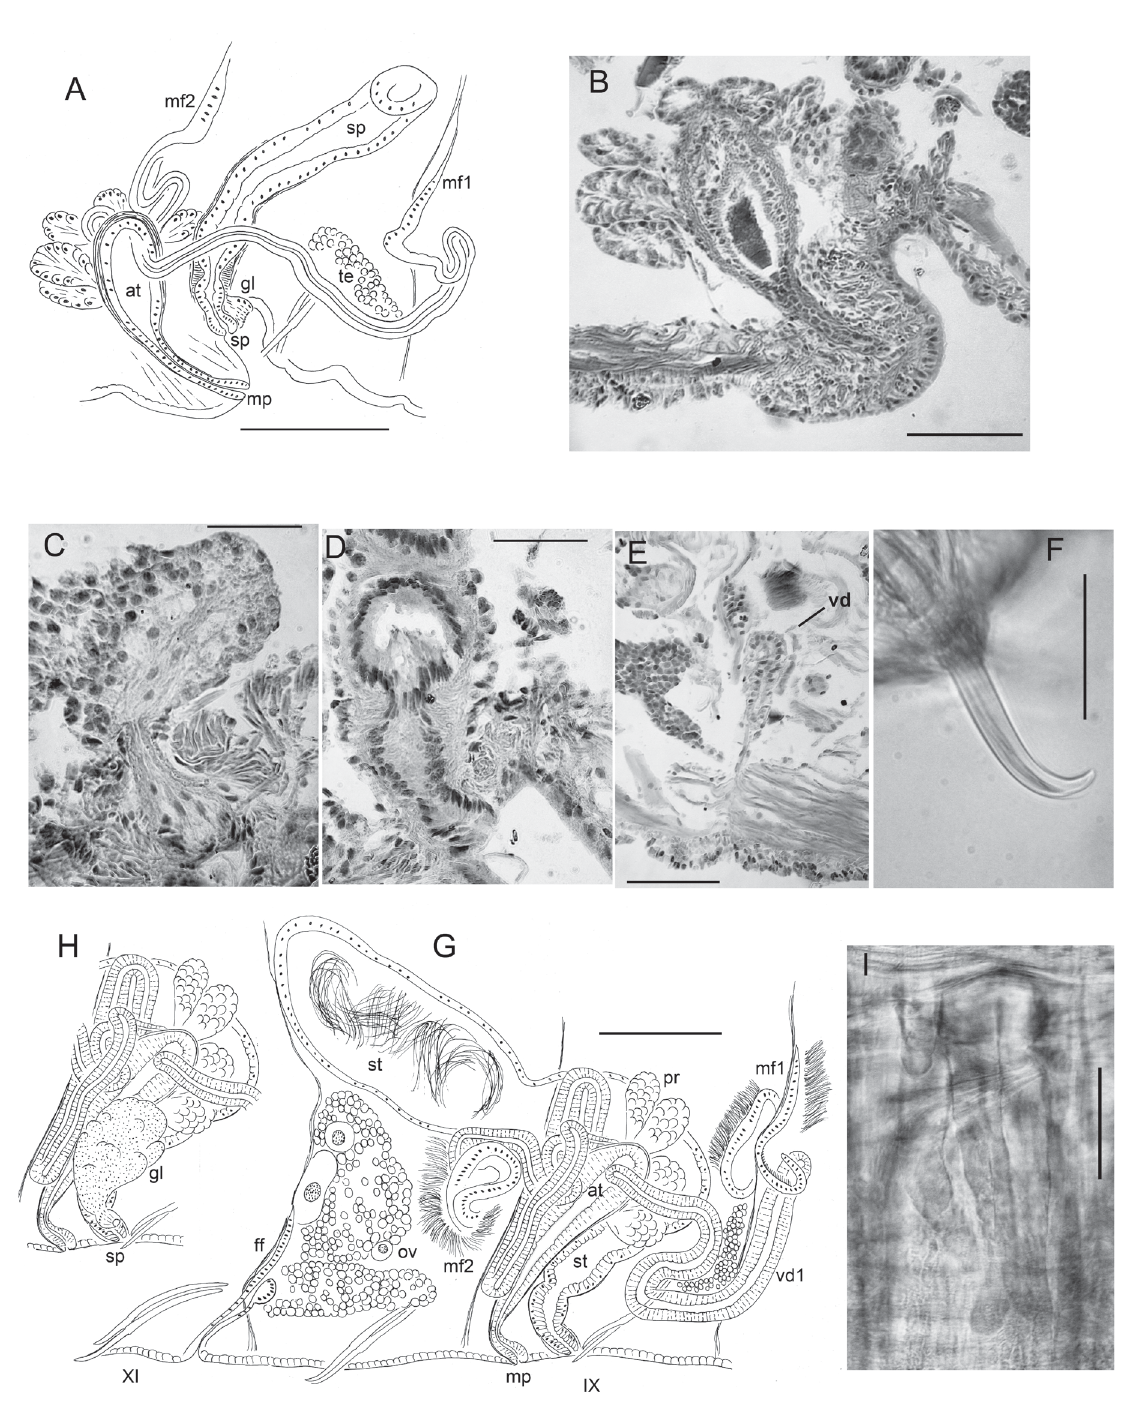
Fig. 6. Guestphalinus wiardi (Michaelsen, 1933); A–E a sectioned worm from Slovenia, Hrabě’s collection; F–I, a dissected Italian specimen. A . Male duct and spermatheca in IX, reconstructed from sections; pore from a copulatory gland (not shown) opens next to spermathecal pore. B . Atrium and male porophore. C . Copulatory gland. D . Spermathecal pore and duct. E . Anterior male funnel with vas deferens entering pre-atrial segment. F . Posterior ventral chaeta, showing grooved dorsal tooth. G . Reproductive organs in IX-XI, figure rotated to face to right. H . Detail of G, showing position of copulatory gland, from median view. I . Branched lateral blood vessel in posterior segment. Scale bars: A, G–H = 200 m m; B, E, I = 100 m m; C–D, F = 50